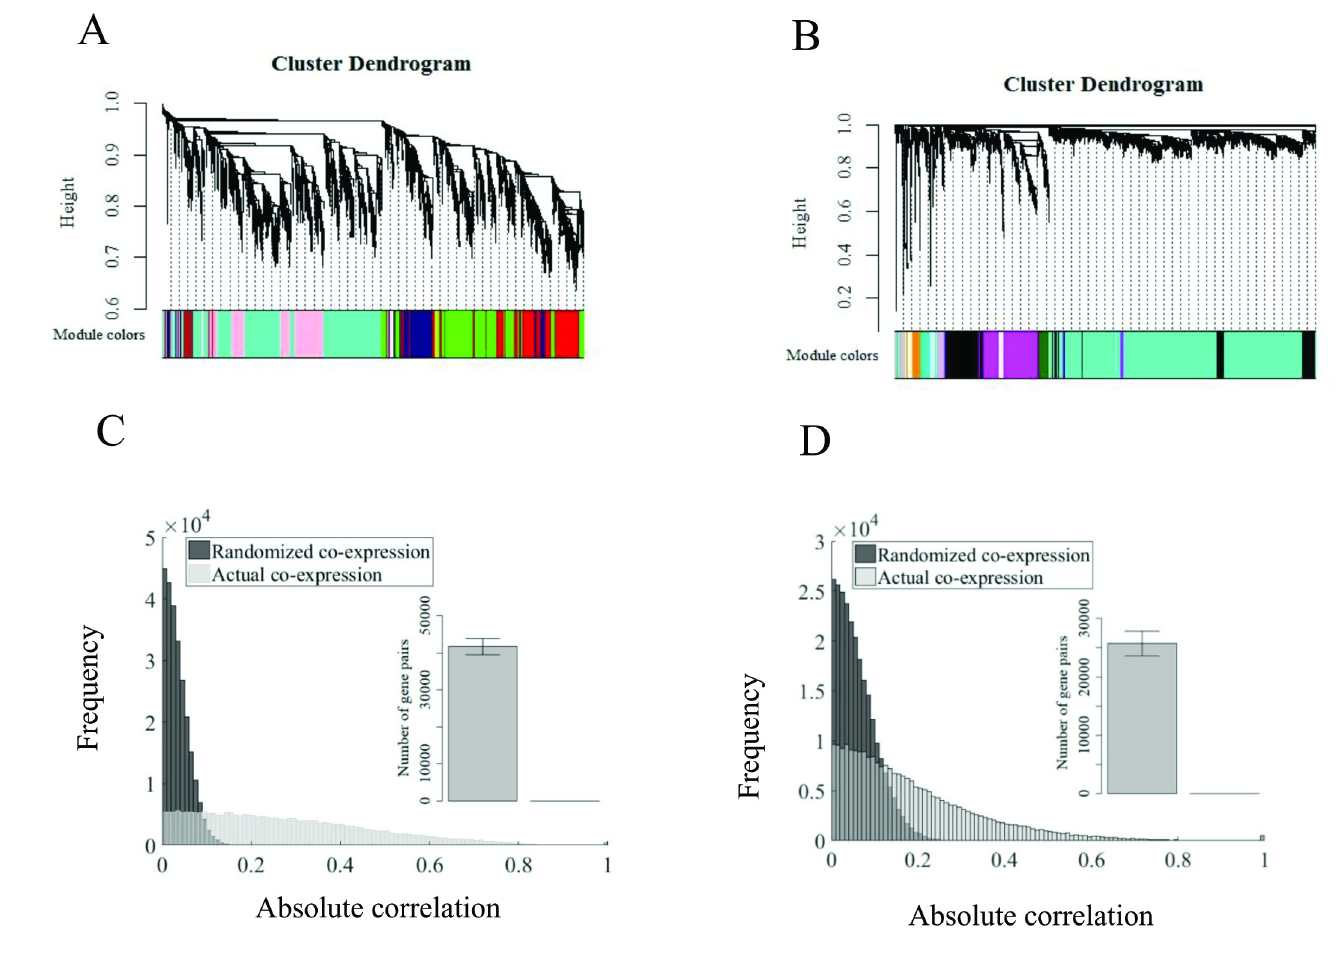
Fig 1. Frequency of co-expression is higher than expected by chance in natural transcriptomes. A and B) Typical co-expression structure and modular organiza-tion of a random sample of 1000 genes from the human brain transcriptome (Brain-span dataset) and 60 brain tissue samples obtained from the Fantom5 dataset. C) and D) Distribution of absolute correlations of all gene pairs in a random sample of 1000 genes compared with the distribution resulting from random permutations of expression data in the same genes. Inset: Bars show the mean ( ± SEM) number of highly correlated pairs (/R/ > 0.5) among 1000 independent samples of 1000 genes each compared with the expected mean number of highly correlated pairs (absolute correlation) resulting from random permutations of the gene expression values in the same